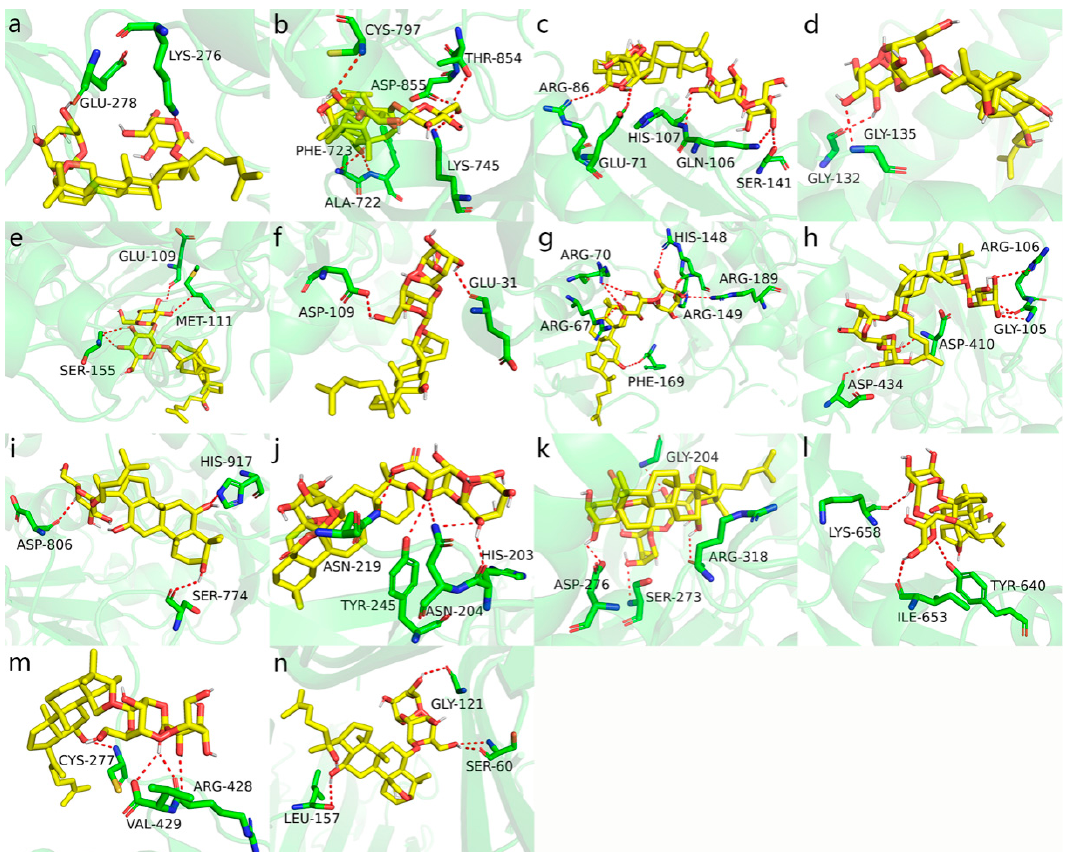
Figure 7. The highest binding energy of ginsenosides docked with each core target. ( a ) AKT1 docking with Ginsenoside F2; the binding energy was − 14.5. ( b ) EGFR docking with 20( S )-Ginsenoside Rg 3 ; the binding energy was − 12.7. ( c ) GRB2 docking with Ginsenoside Ro; the binding energy was − 8.8. ( d ) HSP90AA1 docking with Ginsenoside Rf; the binding energy was − 13.8. ( e ) JUN docking with 20( S )-Ginsenoside Rg 3 ; the binding energy was − 10.7. ( f ) MAPK1 docking with Ginsenoside Rk 1 ; the binding energy was − 13.4. ( g ) MAPK14 docking with Ginsenoside Rk 1 ; the binding energy was − 13.3. ( h ) MMP9 docking with Gypenoside IX; the binding energy was − 10.2. ( i ) PIK3CA docking with Ginsenoside F1; the binding energy was − 12. ( j ) PTPRC docking with Ginsenoside Ro; the binding energy was − 7.1. ( k ) SRC docking with Gypenoside IX; the binding energy was − 12.4. ( l ) STAT3 docking with Ginsenoside F3;the binding energy was − 9.5. ( m ) VEGFA docking with Ginsenoside Rg 5 ; the binding energy was − 8.8. ( n ) TNF docking with Ginsenoside Rf; the binding energy was − 10.7.